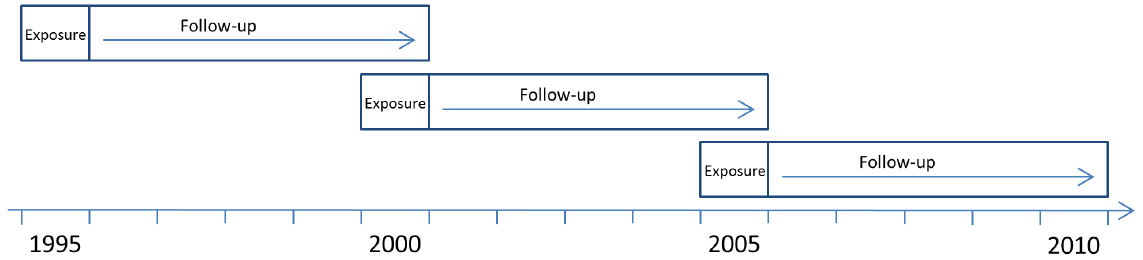
Figure 1. Timeline of the three cohorts. The three cohorts included all individuals 19–23 years of age and living in Sweden in 1995, 2000, and 2005, respectively. Each cohort was followed for five years from the year after inclusion.